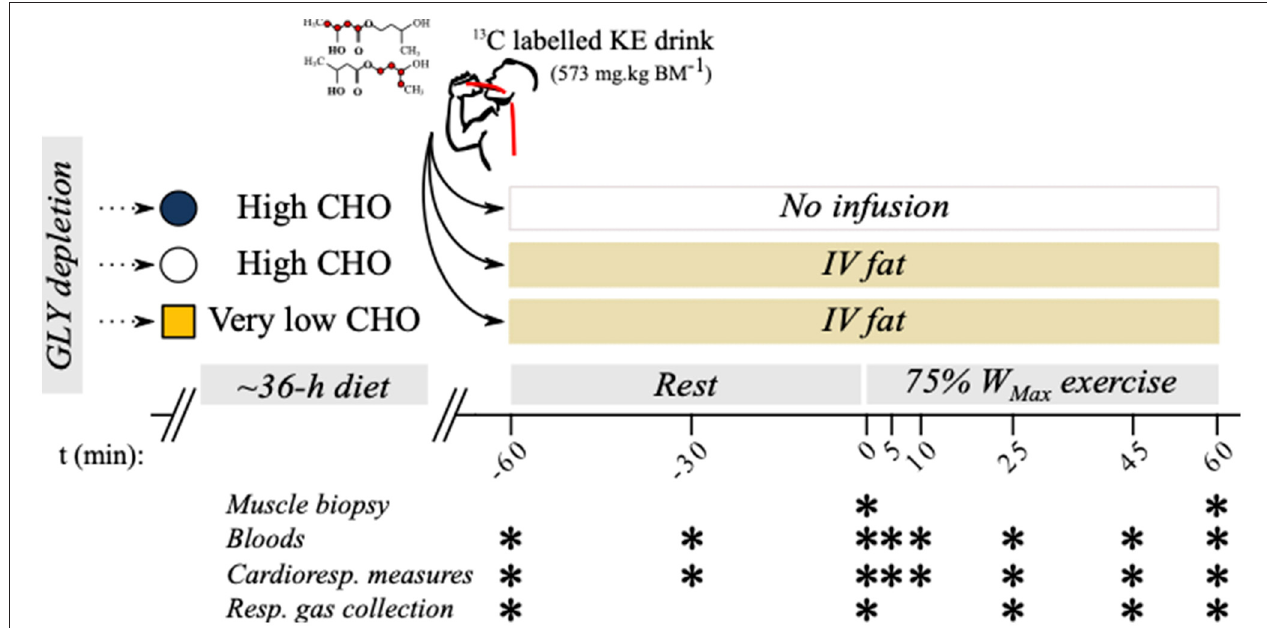
FIGURE 1 | Study protocol overview. Six well-trained athletes were recruited to a 3-way crossover design study where oxidation rates were measured during exercise following manipulations to carbohydrate (CHO) and fat